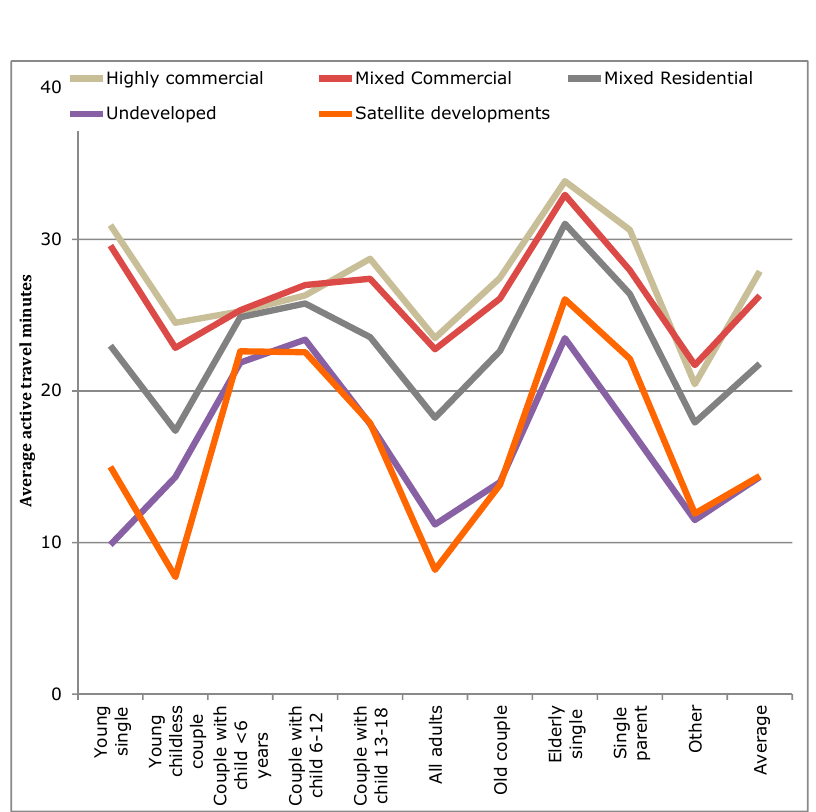
Figure 8. Changes in average active transport time per person for each built environment by lifecycle stage.